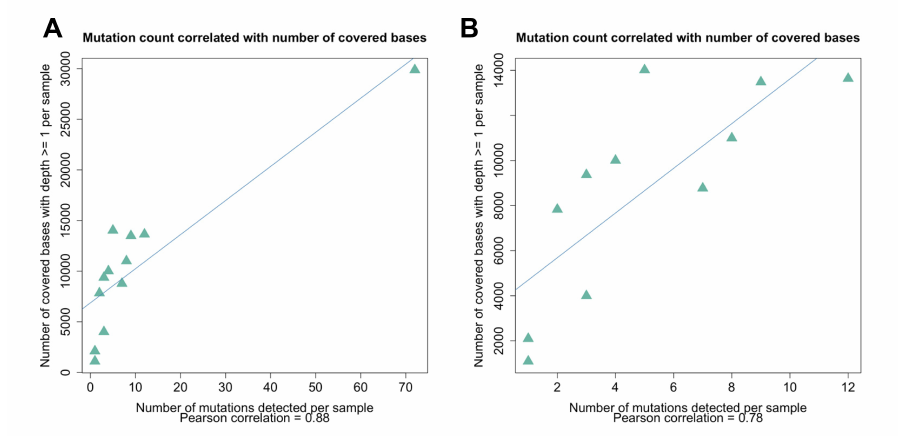
Figure 7. Correlation between the genome coverage depth and the number of mutations detected. ( A ) The mutation count was correlated with the number of bases (nucleotide positions) covered by one or more reads (Pearson correlation of 0.88). ( B ) The removal of the sample that had extremely high coverage and a large number of mutations detected (Lucas 122020) resulted in a lower but still significant correlation (Pearson correlation of 0.78).